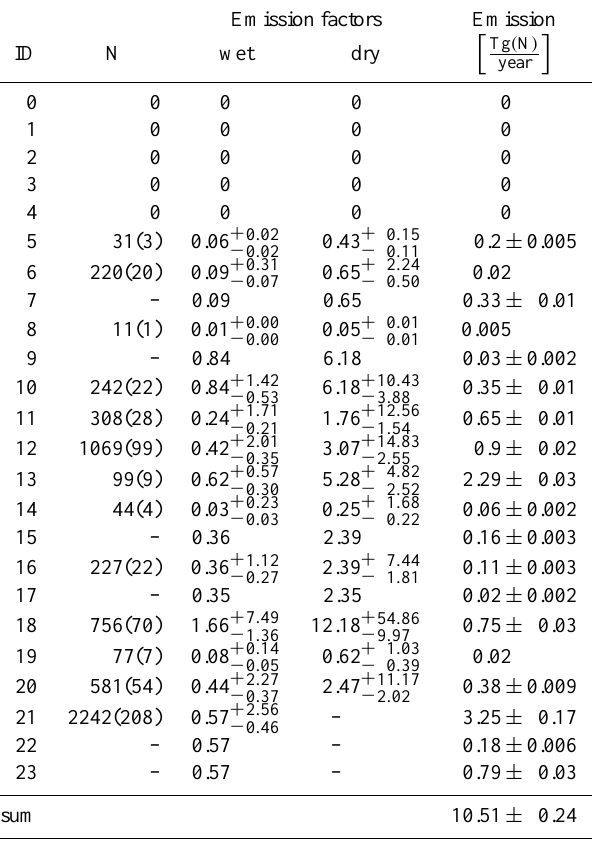
Table 5. The adopted (YL95/SL11) emission factors (geomet- ric mean) and associated soil biogenic NO emissions. When not shown, standard deviations are less than or equal to